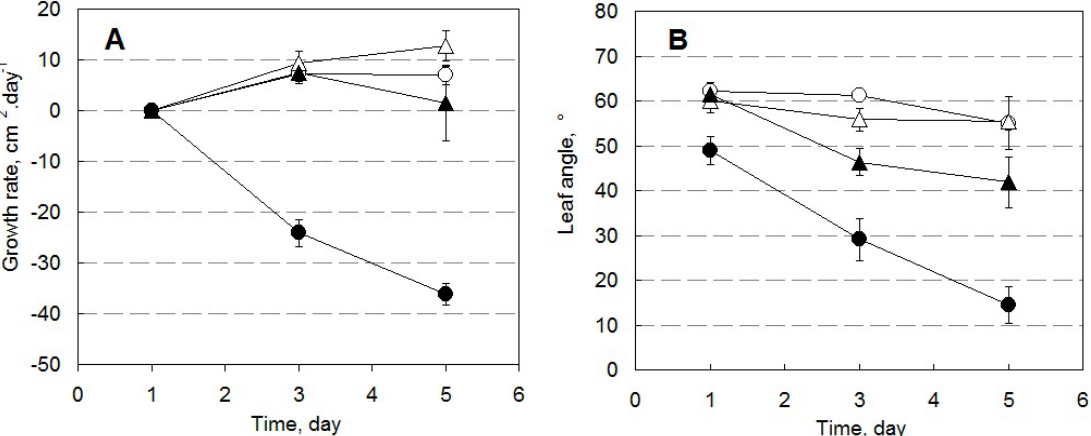
Figure 7. Growth rate and leaf angle measurement by 3D reconstructions . ( A ) The growth rate measured by expansion (positive values) or reduction (negative values) of integral plant leaf area per day during five consecutive days. ( B ) The angle between the camera optical axis and the leaf plane. The wilting in the high light drought stressed plants (HS) and, partially, also in the low light drought stressed plants (LS) is reflected in a decreased leaf angle. Pepper plants were cultivated for five days in following conditions: HW ([ ○ ], 450 μ mol (photons) m − 2 ·s − 1 of PAR, 100% pot water capacity), HS ([ ● ], 450 μ mol (photons) m − 2 ·s − 1 of PAR, 30% pot water capacity), LW ([ Δ ], 85 μ mol (photons) m − 2 ·s − 1 of PAR, 100% pot water capacity), and LS conditions ([ ▲ ], 85 μ mol (photons) m − 2 ·s − 1 of PAR, 30% pot water capacity). Symbols represent mean values of three plant measurements ± standard